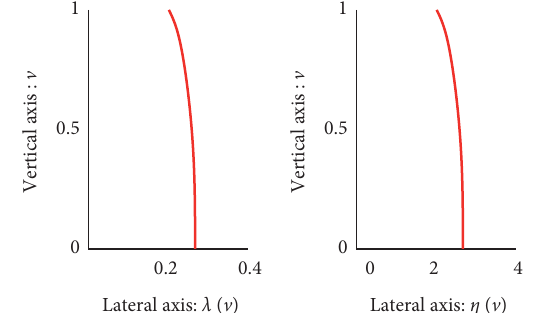
Figure 4: Default polygons using isoparametric series u � const and v � const in